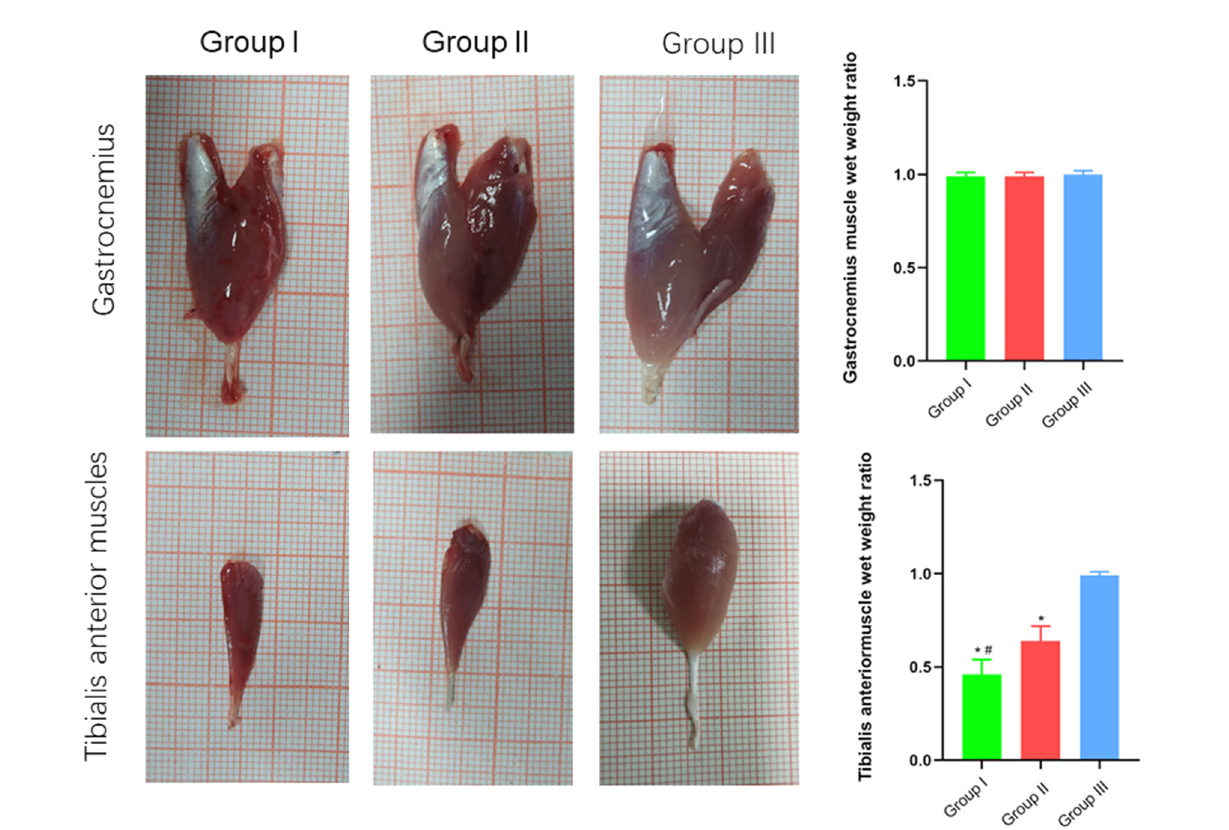
FIGURE6 Macroscopic specimen observation of gastrocnemius and tibialis anterior muscles. In Group I, only the distal end of the common peroneal nerve was repaired; in Group II, both proximal and distal ends of the common peroneal nerve was repaired; Group III was sham operated normal group. Data are expressed as mean ± SD ( n = 6 in Group I, 6 in Group II and 6 in Group III). * P < 0.05, vs. Group III; # P < 0.05, vs. Group